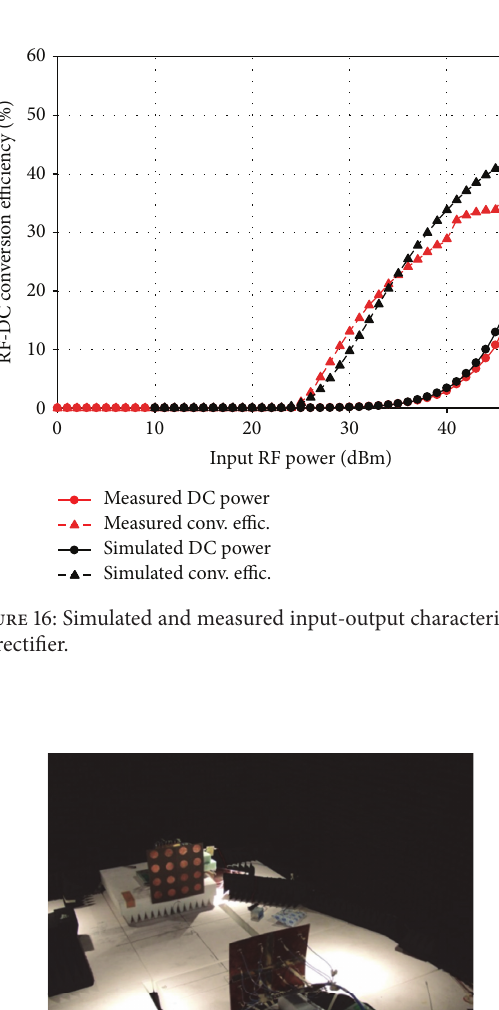
Figure 15: Simulated and measured results for optimal load resis- tance.